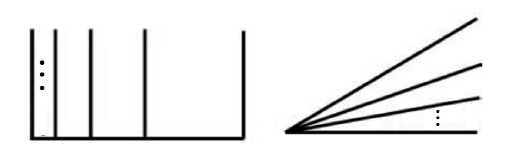
Figure 2. The comb and harmonic fan dendroids.